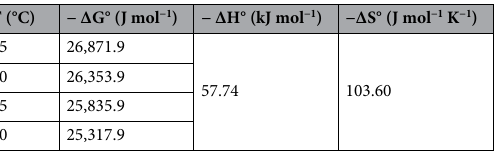
Table 3. Thermodynamic parameters of RO16 adsorption by lignocellulosic sawdust-Fe/Zn composite.